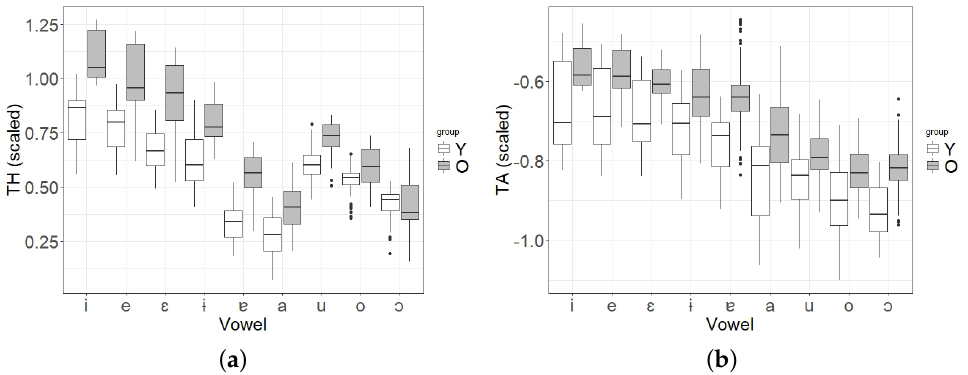
Figure 7. Boxplots of TH ( a ) and TA ( b ) values by vowel and age group. Figure 8 represents the articulatory vowel space defined by scaled TA and TH values of the cardinal EP oral vowels ([a], [i], and [u]) for each speaker and vowel context (i.e., pVCv and isolated vowel). Each vowel is represented by the mean TH and TA. As four old females (O1, O2, O4, and O5) presented incomplete data, it was not possible to define the articulatory space of all speakers by vowel context. Furthermore, the young females also showed great variability in the shape of the articulatory vowel space. Concerning the vowel context, it can be observed that articulatory space tends to be smaller when vowels occur in pVCv sequences comparing with isolated vowels, namely for the speakers Y2, Y3, Y5, and